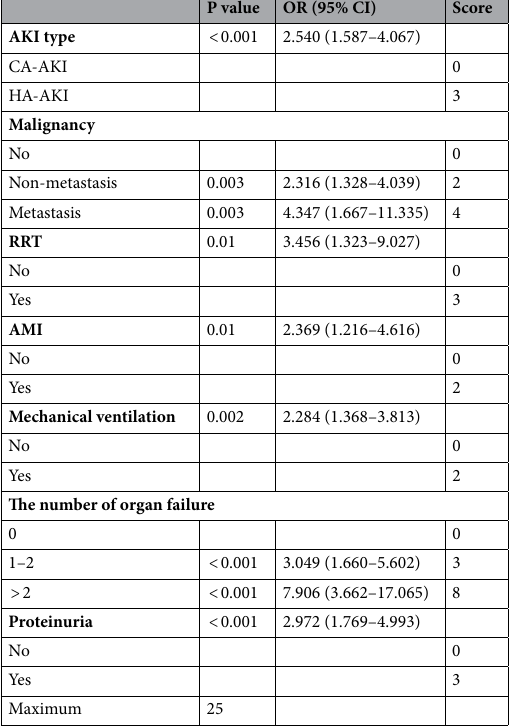
Table 2. Seven-variable risk index for affecting 1-year mortality in the hospitalized elderly patients with AKI. AKI acute kidney injury, CA-AKI community acquired AKI, HA-AKI hospital acquired AKI, AMI acute myocardial infarction, RRT renal replacement therapy, CI confidence interval, OR odds ratio.